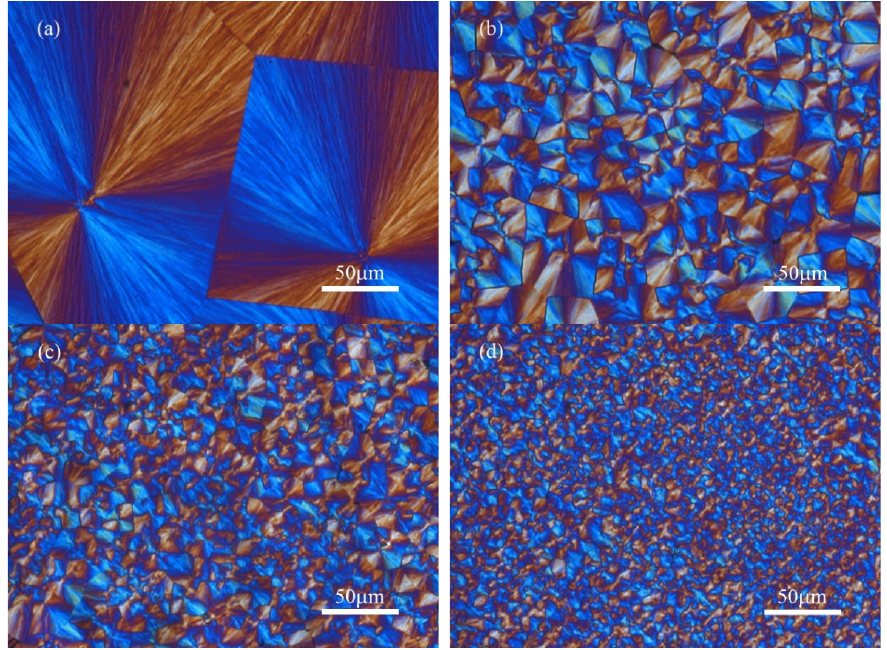
Figure 6. POM micrographs for ( a ) PEPS, ( b ) PEPS/CNC0.25, ( c ) PEPS/CNC0.5, and ( d ) PEPS/CNC1 at 63 °C.